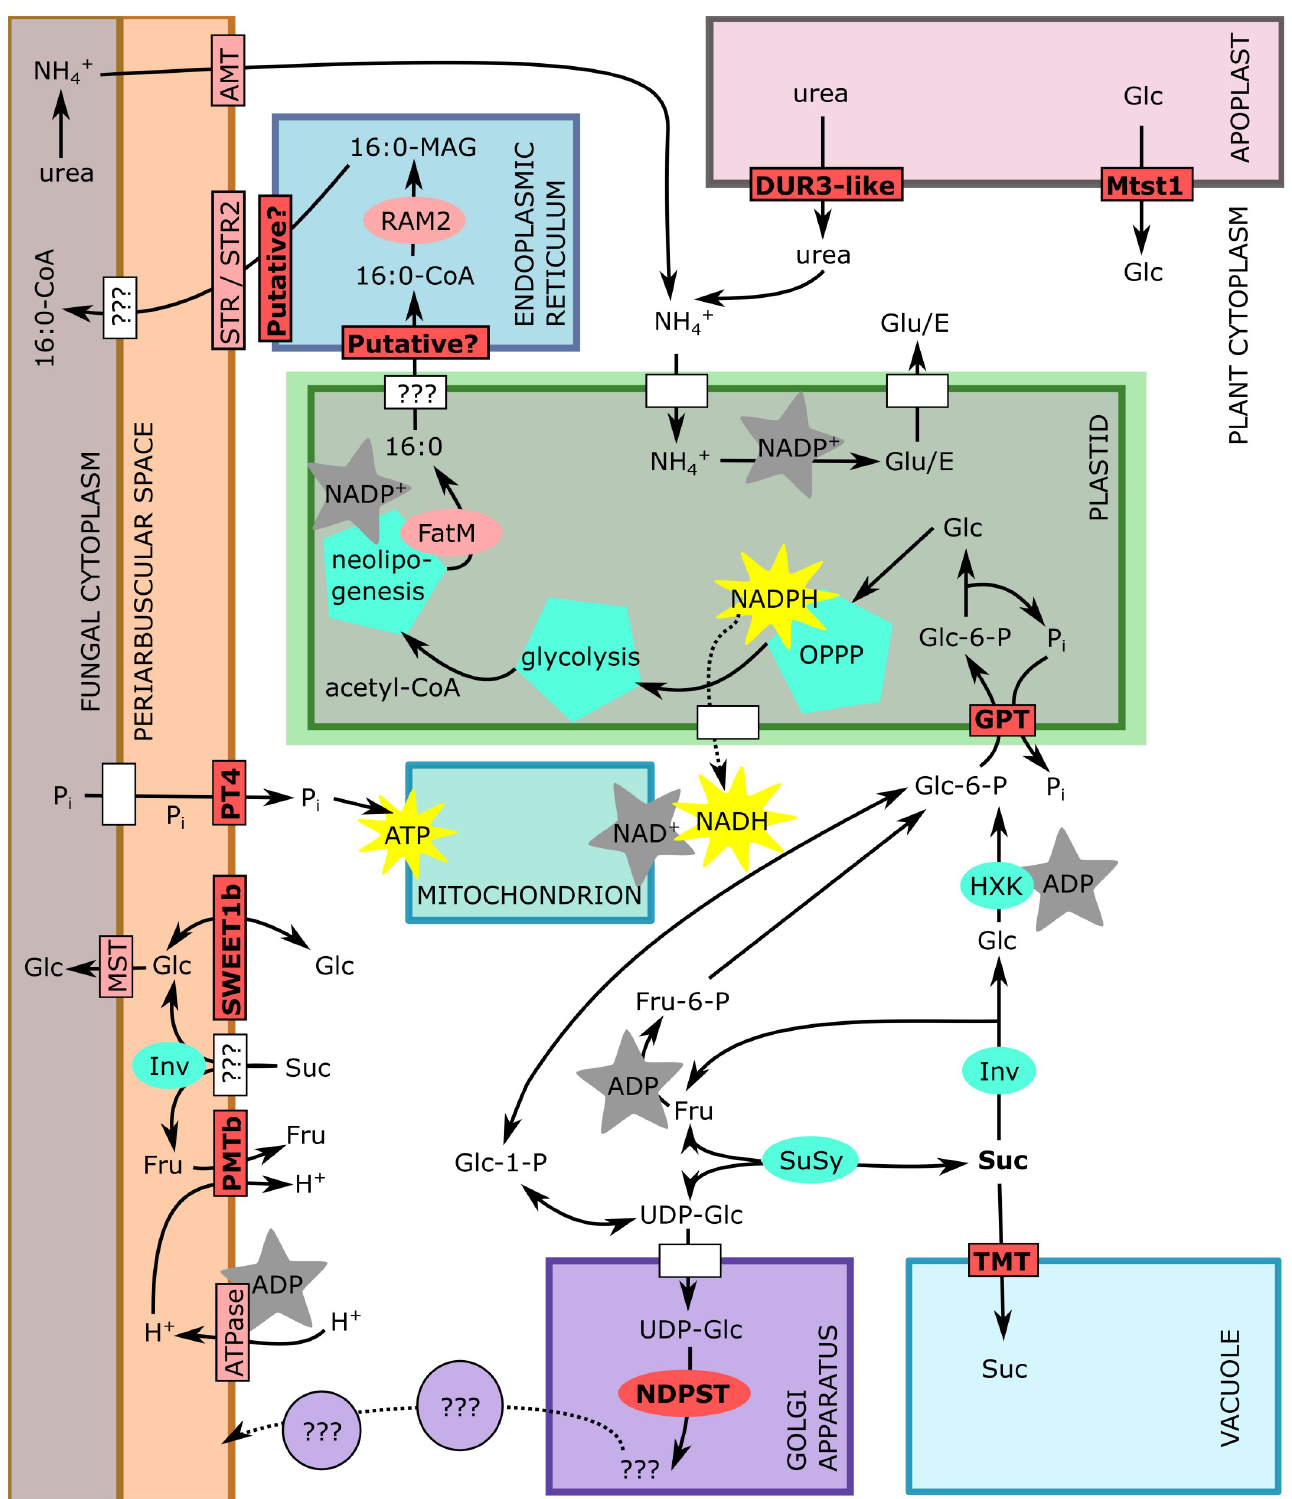
Fig 5. Scheme of arbuscocyte showing genes specifically studied in our research (bright red), and some other of AM symbiosis-relevant proteins (light red), enzymes and enzymatic pathways (cyan), and not specified proteins (white). Generation of energy molecules (ATP) and reductive coenzymes (NADH / NADPH) is indicated by yellow stars, while consuming those compounds is indicated by gray stars. 16:0, free palmitoyl; 16:0-CoA, palmitoyl-Coenzyme A;